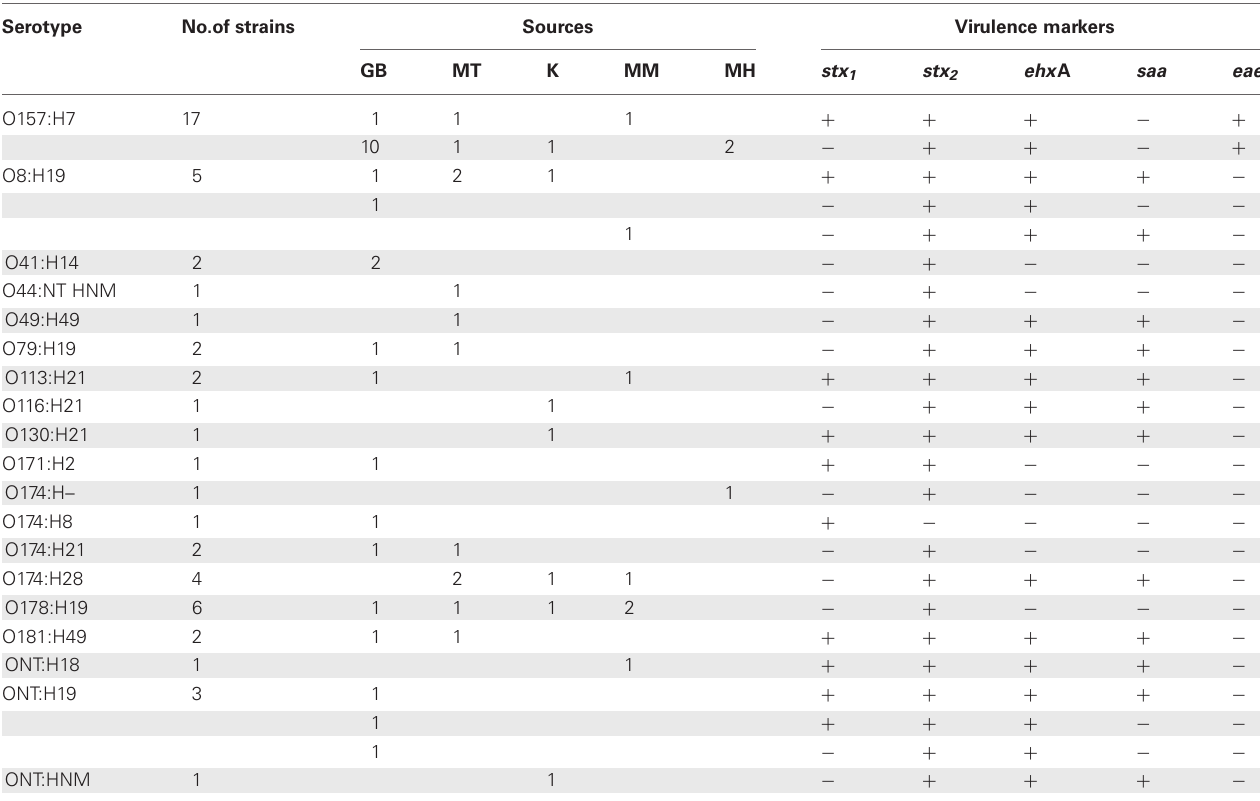
Table 2 | Serotypes, source, Shiga toxin genotypes and other virulence markers of the strains studied. Serotype No.of strains Sources Virulence